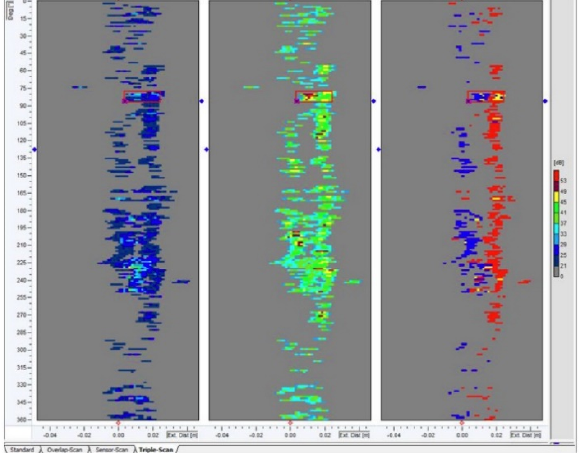
Figure 7. Signal of GW 7050.